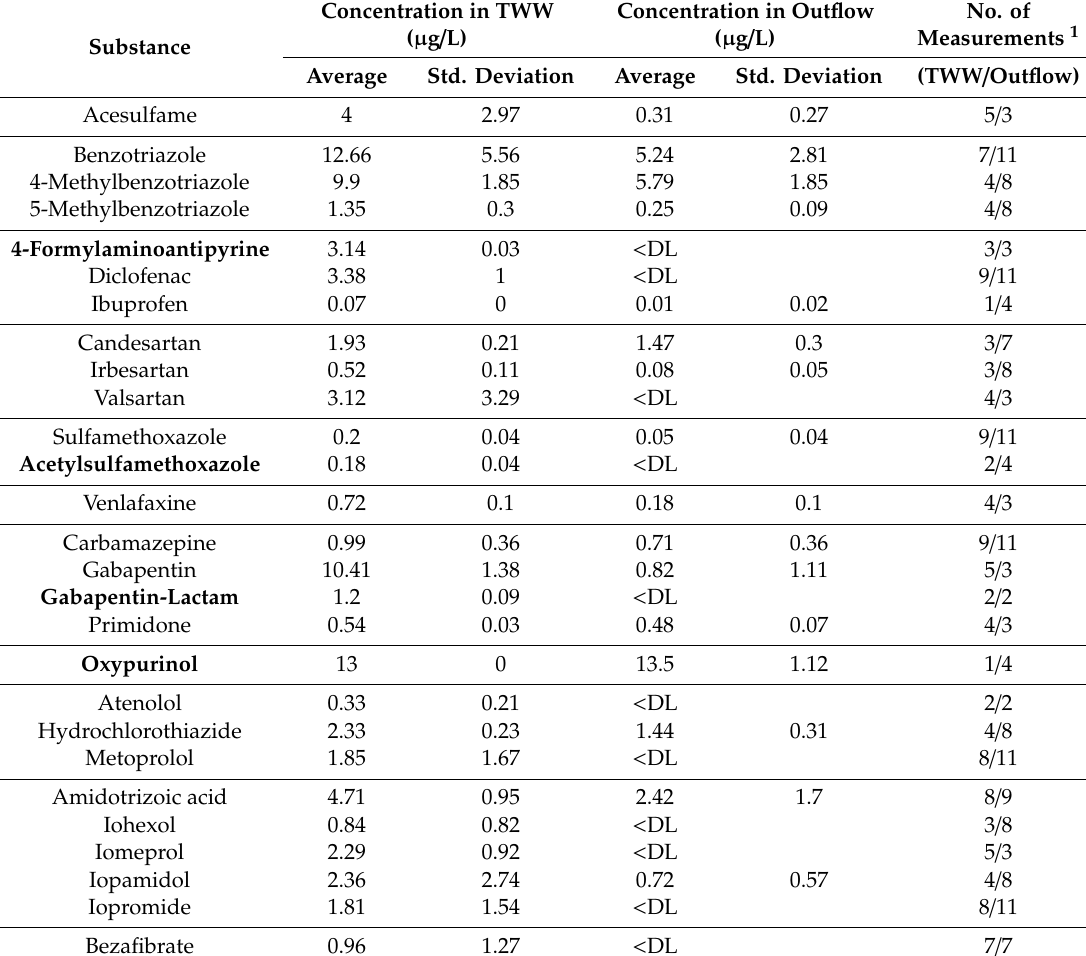
Table 5. Concentration of CECs at influent source (TWW) and at the outlet of the 6 m column averaged over a maximum of 9 (TWW) and 11 (outflow) di ff erent experimental scenarios. Concentrations are given in µ g / L. < DL: below the detection limit (DL). The metabolites are highlighted in bold. Concentration in TWW Concentration in Outflow No. ( µ g / L) ( µ g / L) Substance